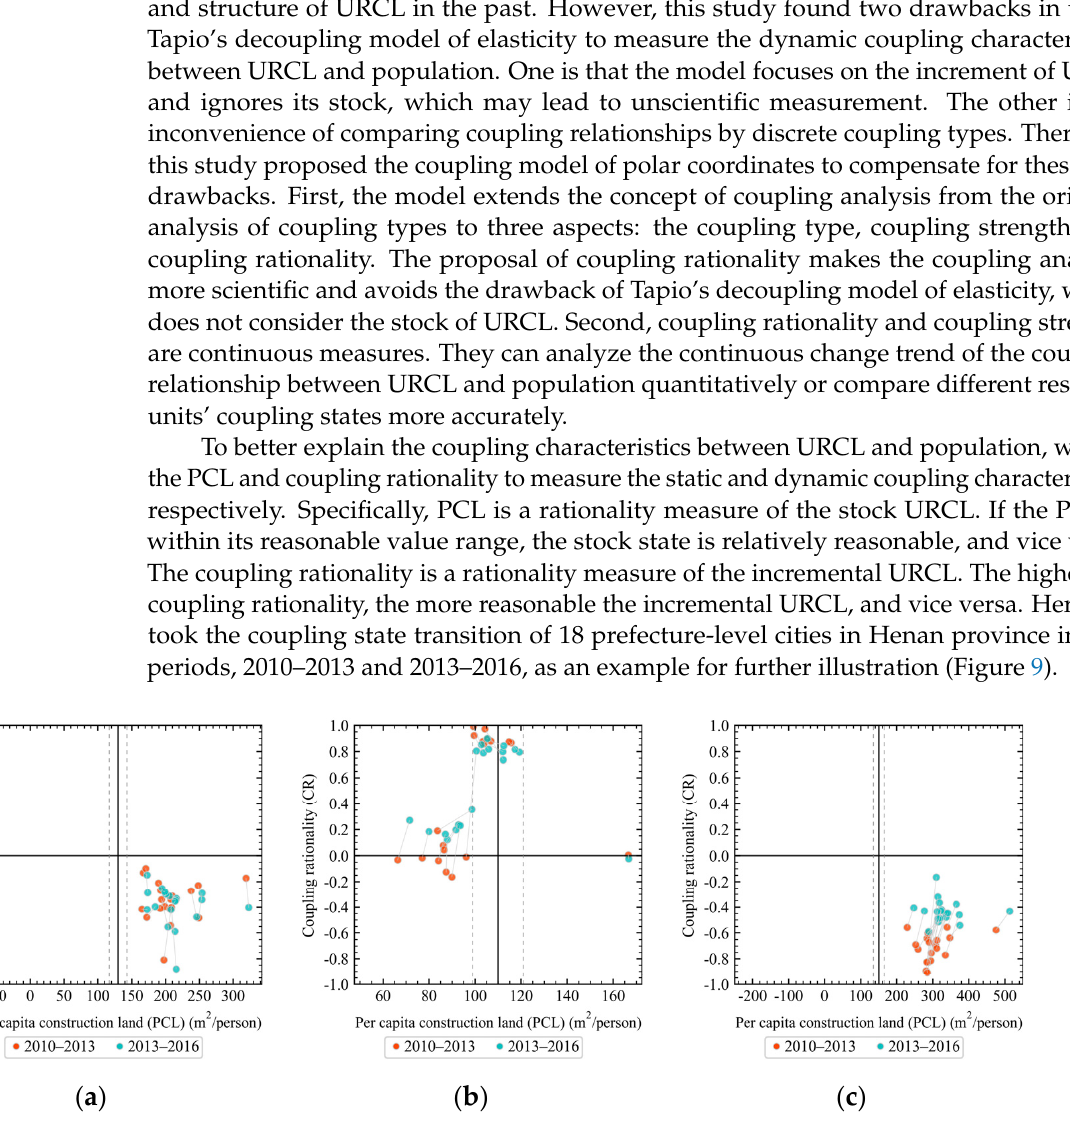
Figure 9. Transition analysis of the coupling state between URCL and population in Henan province from 2010 to 2016: ( a ) coupling state transition of URCL–URP; ( b ) coupling state transition of UCL–UP; ( c ) coupling state transition of RCL–RP.